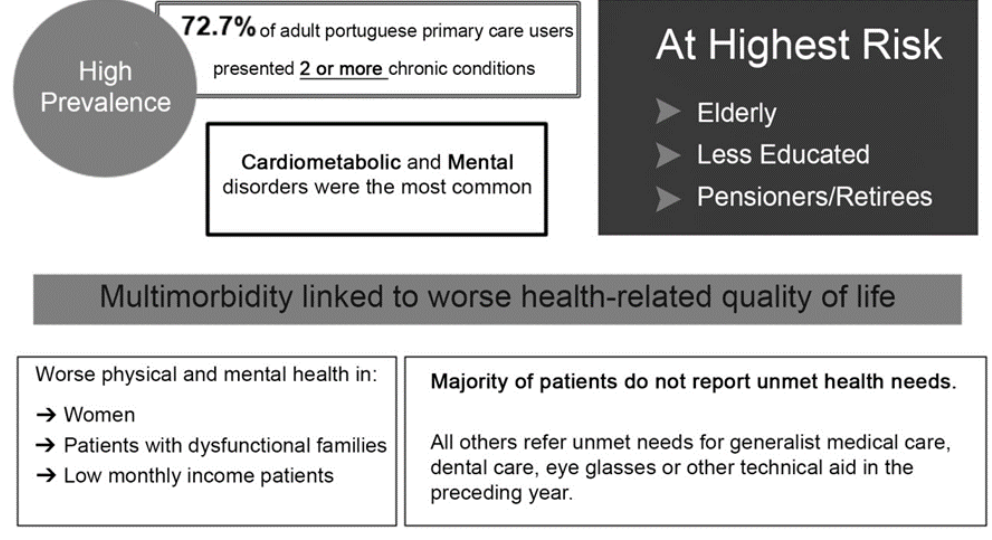
Figure 1. Informational material depicting results of our previous studies on multimorbidity in Portugal.